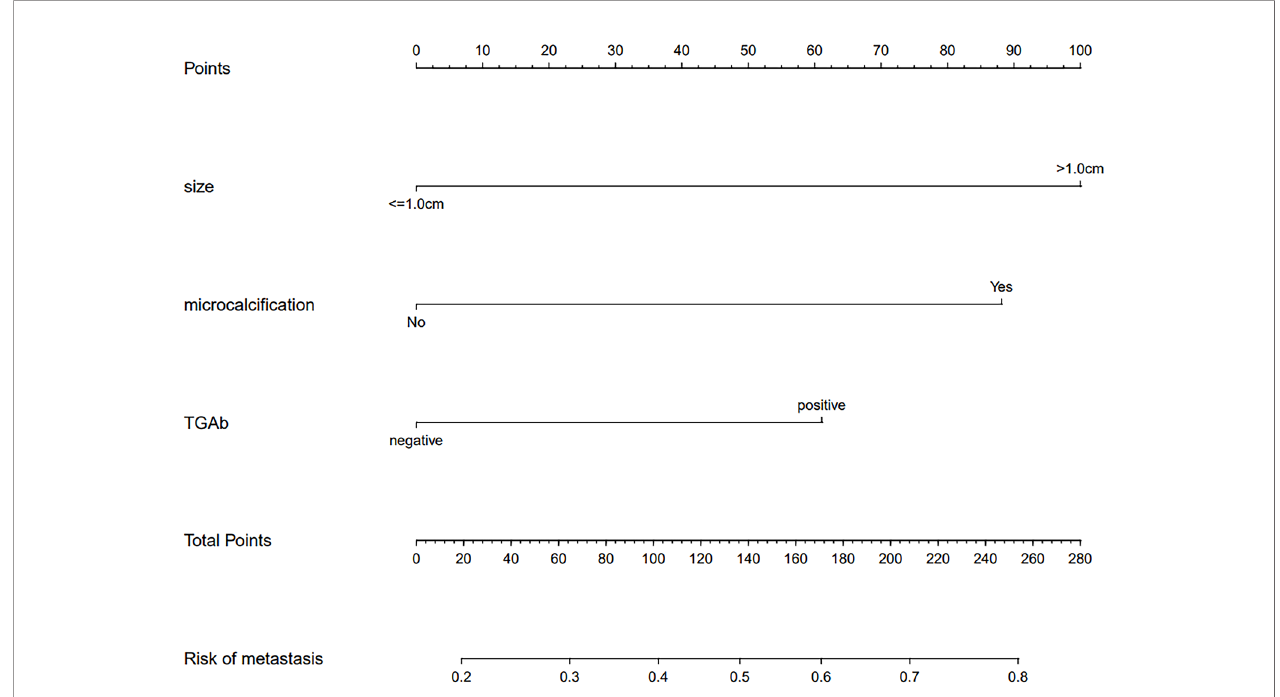
FIGURE 4 | A prediction nomogram. The nomogram is used for the prediction of central CLNM in PTC patients (cN0). The prediction nomogram was developed in the cohort, with tumor size, US feature (microcalci fi cations), and thyroglobulin antibody